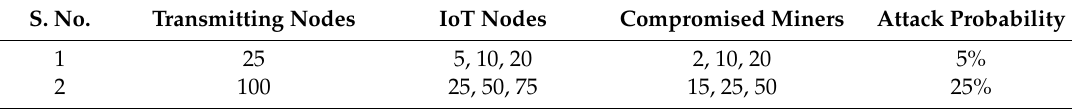
Table 2. The configuration of NS2 for a di ff erent network